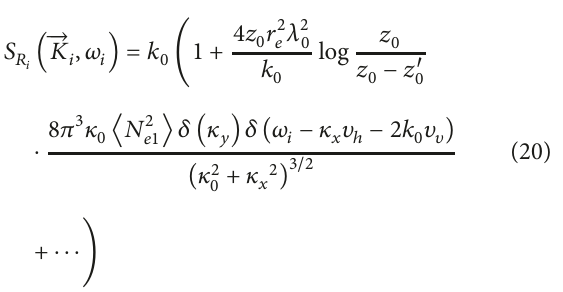
Figure 4: Scattering geometry for ionospheric